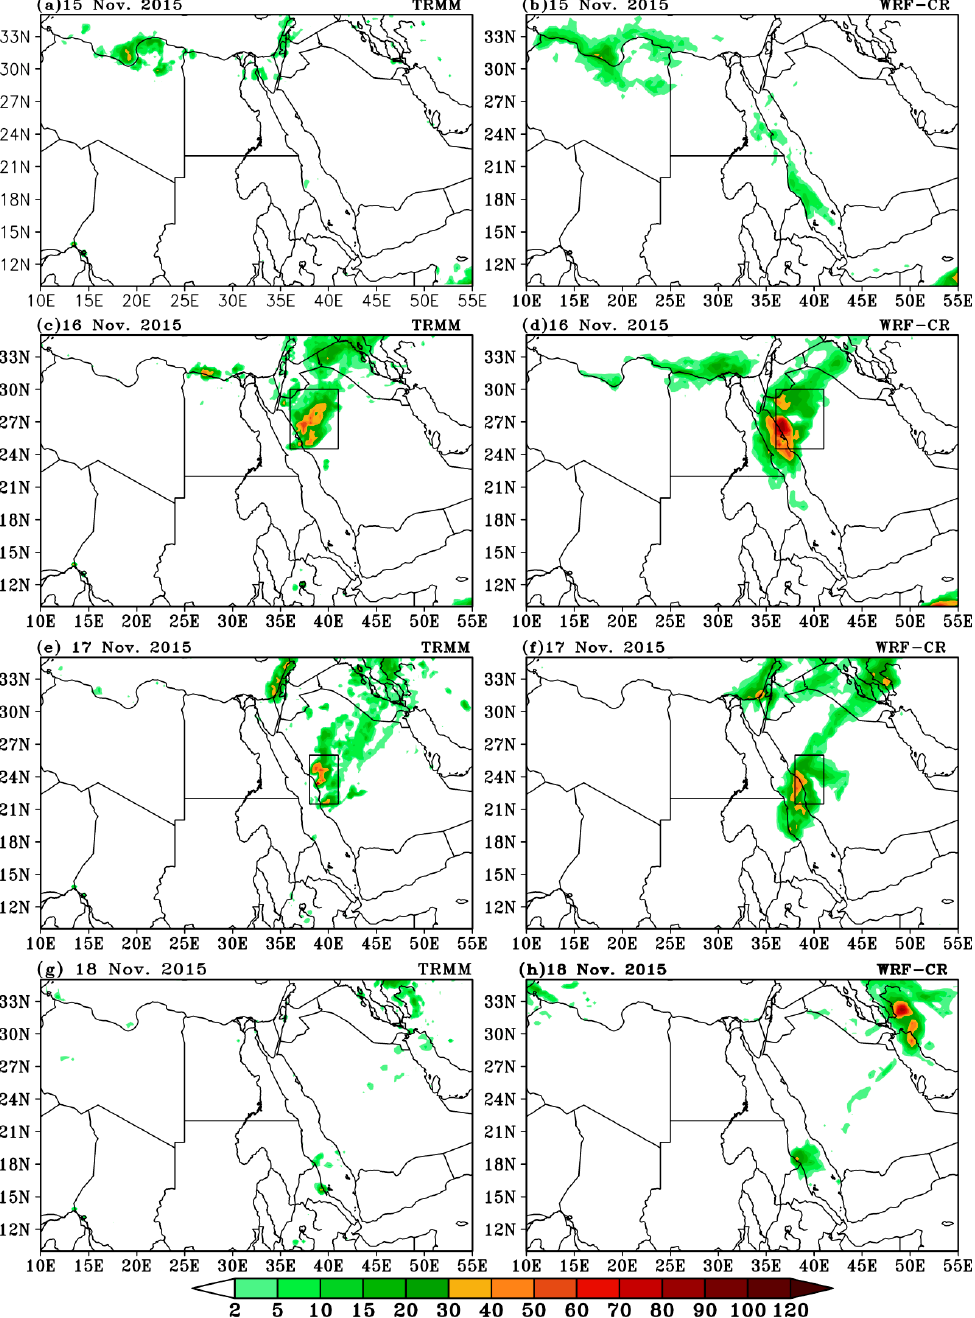
Figure 6. The daily spatial rainfall pattern from the TRMM dataset ( a , c , e , g ) and the WRF control run ( b , d , f , h ) for the period 15–18 November 2015.